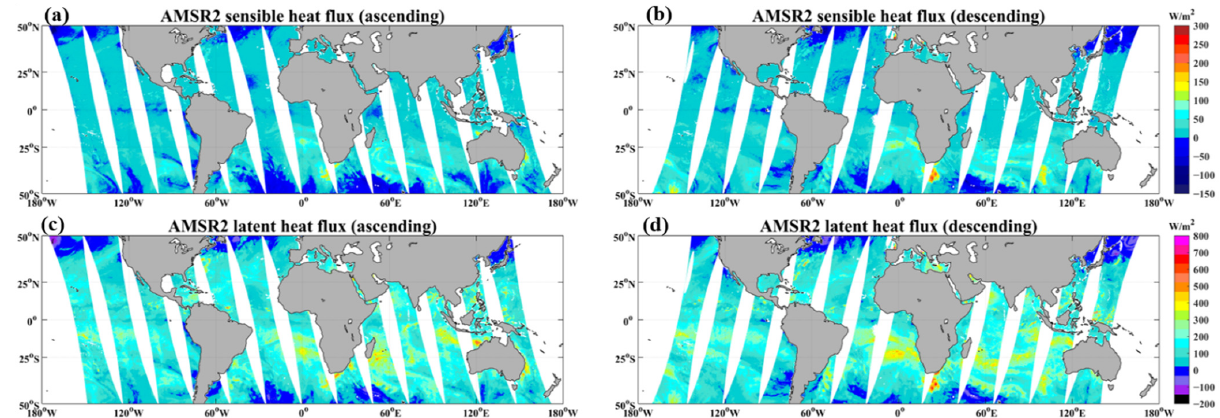
Figure 9. The global daily instantaneous fields of sensible heat flux and latent heat flux estimated from COARE 3.5 and the multi − parameter BPNN model-retrieved air − sea interface parameters (WS, T s , T a , RH) for 13 July 2018. Panels ( a , c ) represent ascending overpasses, and ( b,d ) stand for descending overpasses.